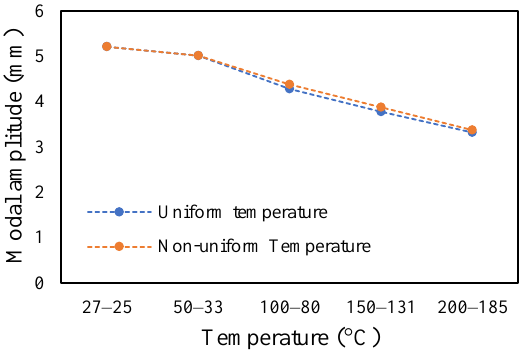
Figure 22. Comparison of natural frequency of 1 mm crack depth ramped at 2 °C/min.